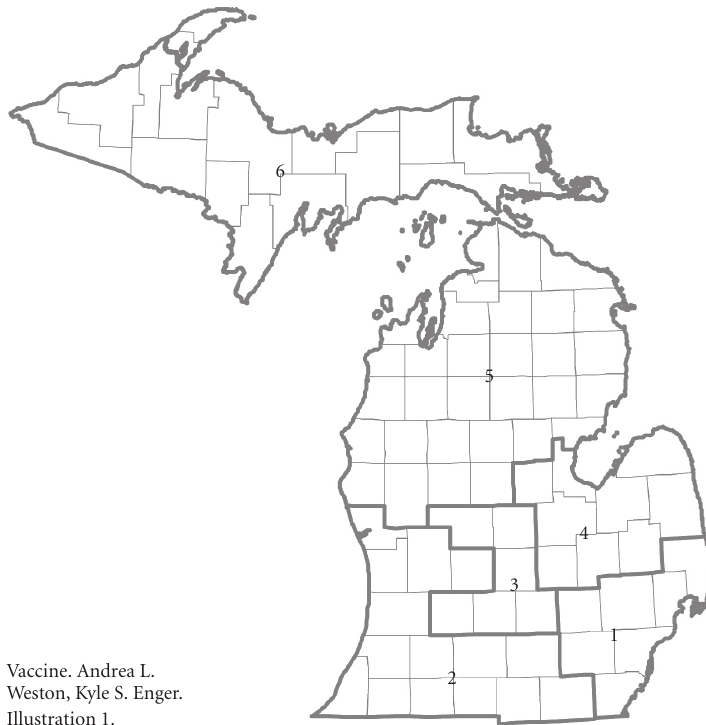
Figure 1: Regional map of the State of Michigan, as defined by Michigan Care Improvement Registry (MCIR).